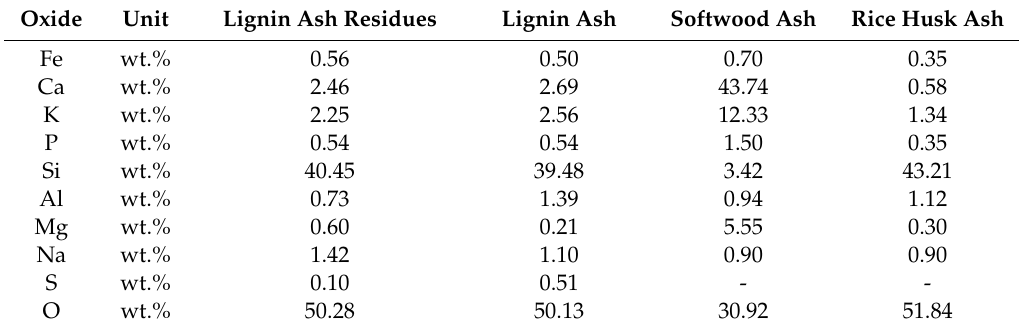
Table 4. X-ray fluorescence (XRF) analysis of wheat straw lignin ash residues, wheat straw lignin ash, softwood ash and rice husk ash